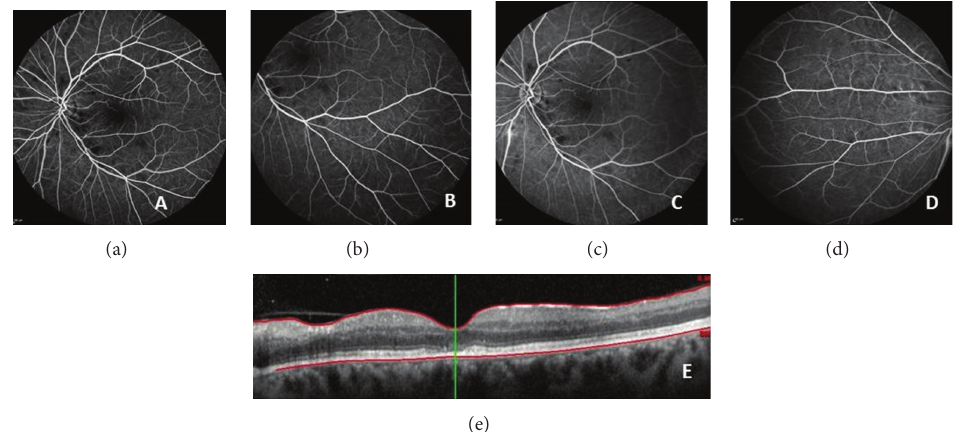
Figure 3: Early, intermediate and late phases of fluorescein angiography ((a), (b), (c), and (d)) and OCT (e) after 1 month of treatment with oral prednisolone and intravitreal bevacizumab.